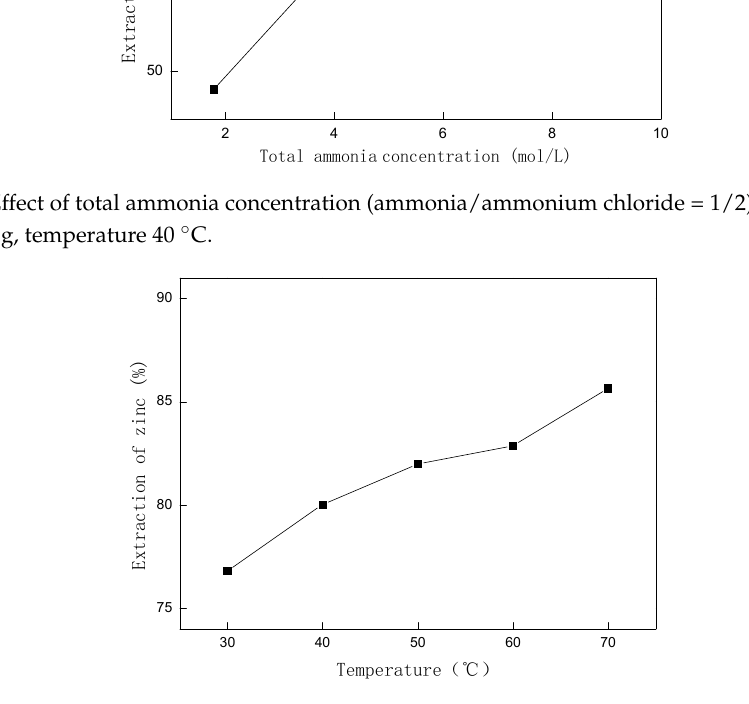
Figure 8. Effect of temperature (Time 30 min, L/S 6 mL/g, concentrations of ammonia and ammonium chloride, 2.5 mol/L and 5 mol/L respectively).